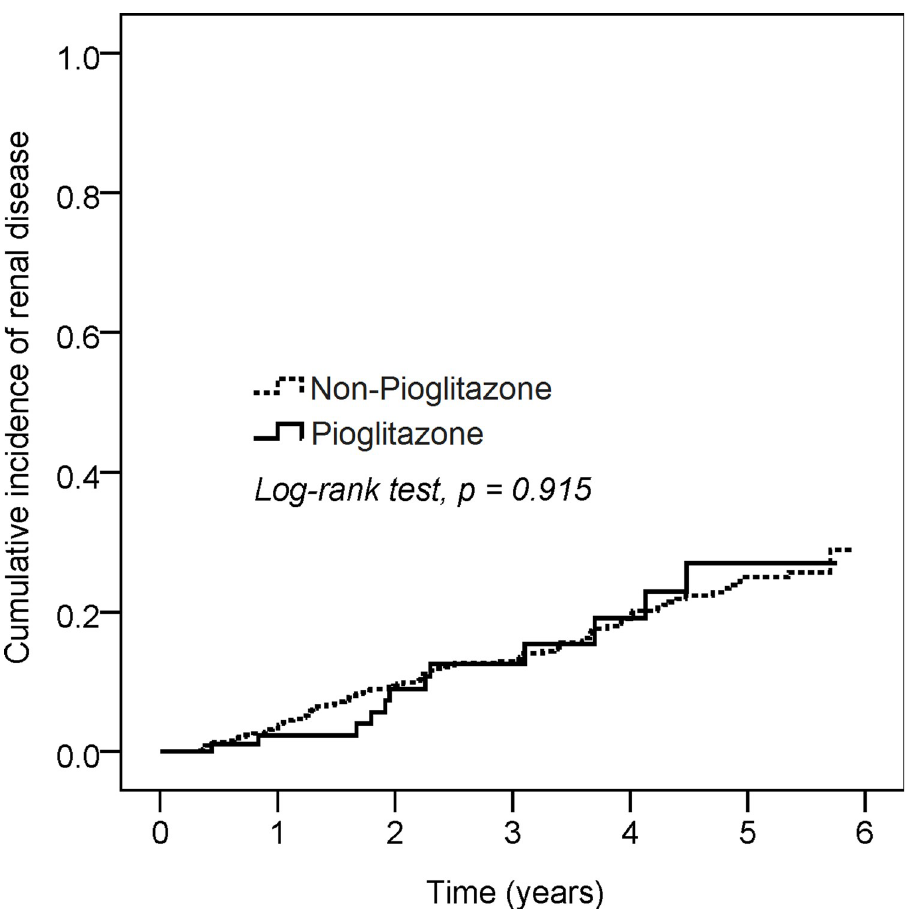
Fig 4. Kaplan-Meier analysis of renal disease between Pioglitazone and non- Pioglitazone users.